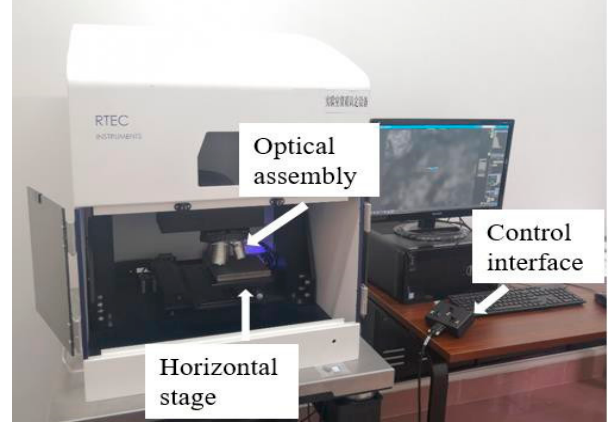
Figure 8. RTEC confocal surface profiler.